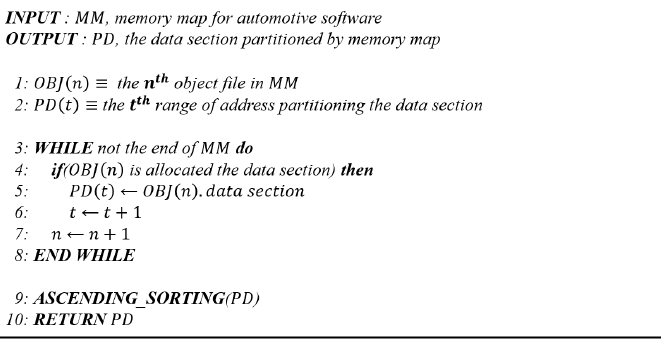
Figure 7. Algorithm for partitioning the data section by memory map.